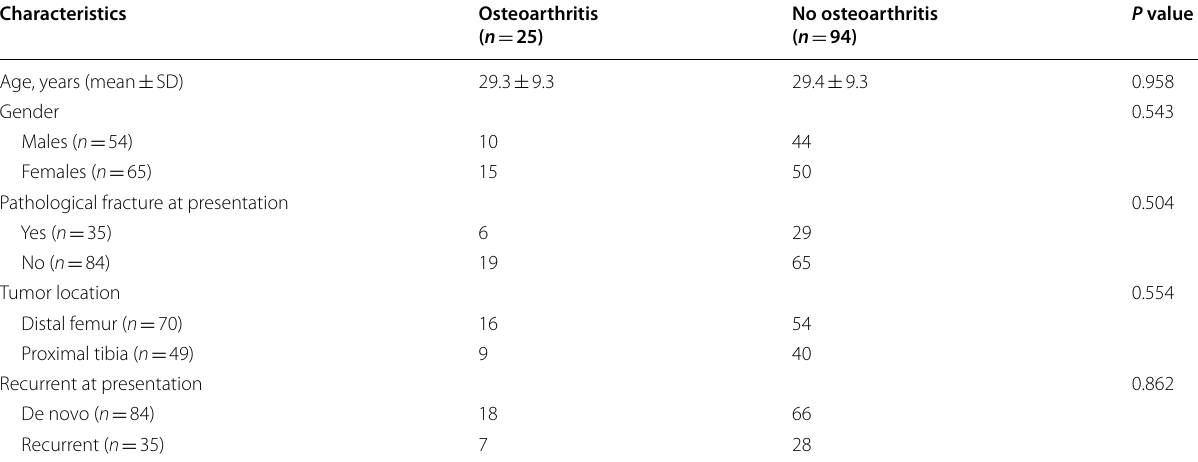
Table 2 Factors affecting the incidence of secondary osteoarthritis Characteristics